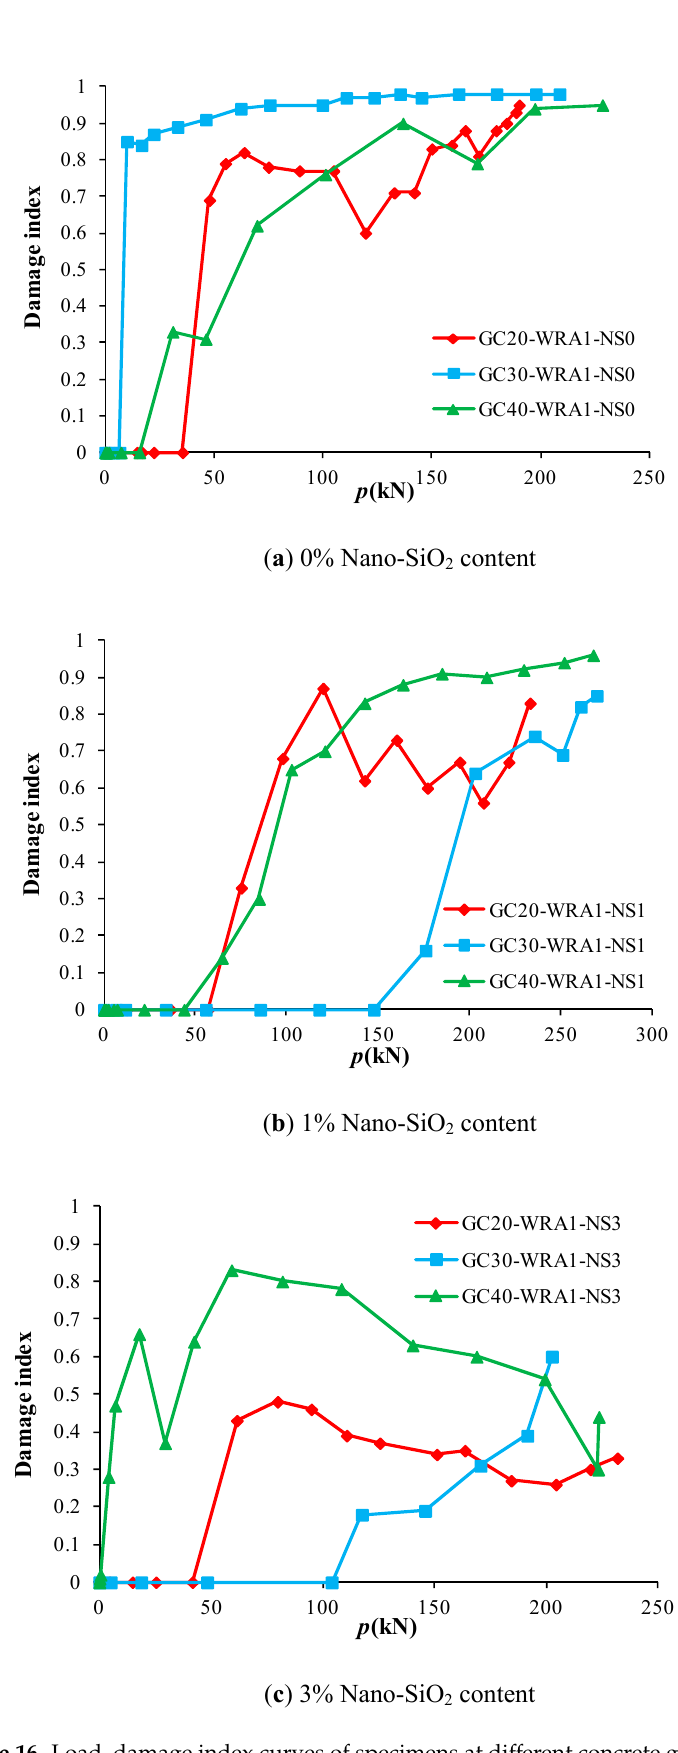
Figure 16. Load–damage index curves of specimens at different concrete grades.